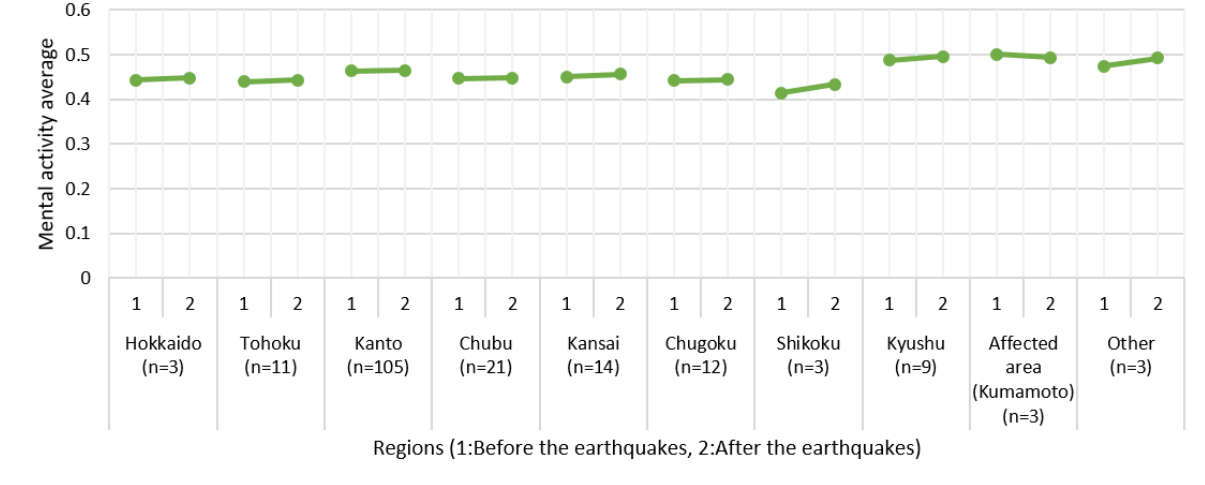
Figure 12. Changes in mental activity before and after the Kumamoto